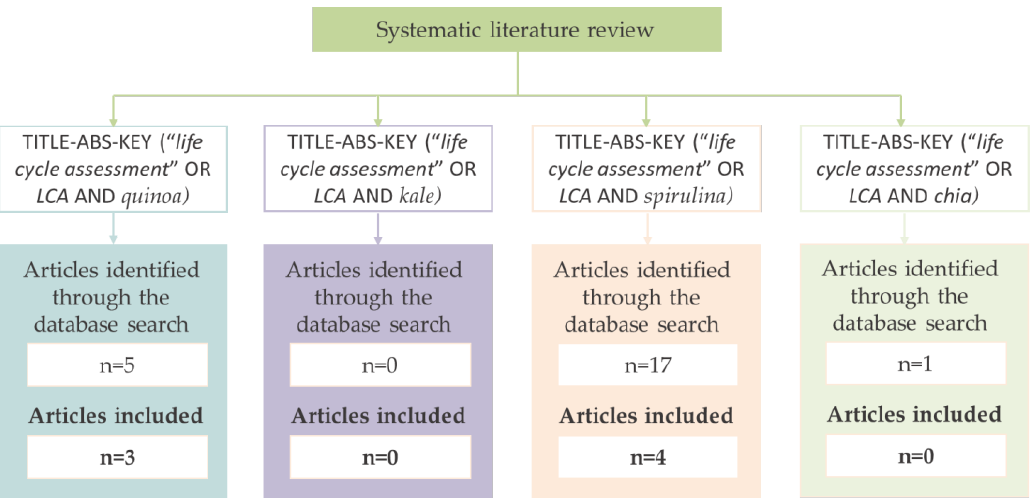
Figure 1. Methodology and results of the bibliographic search conducted in Scopus.